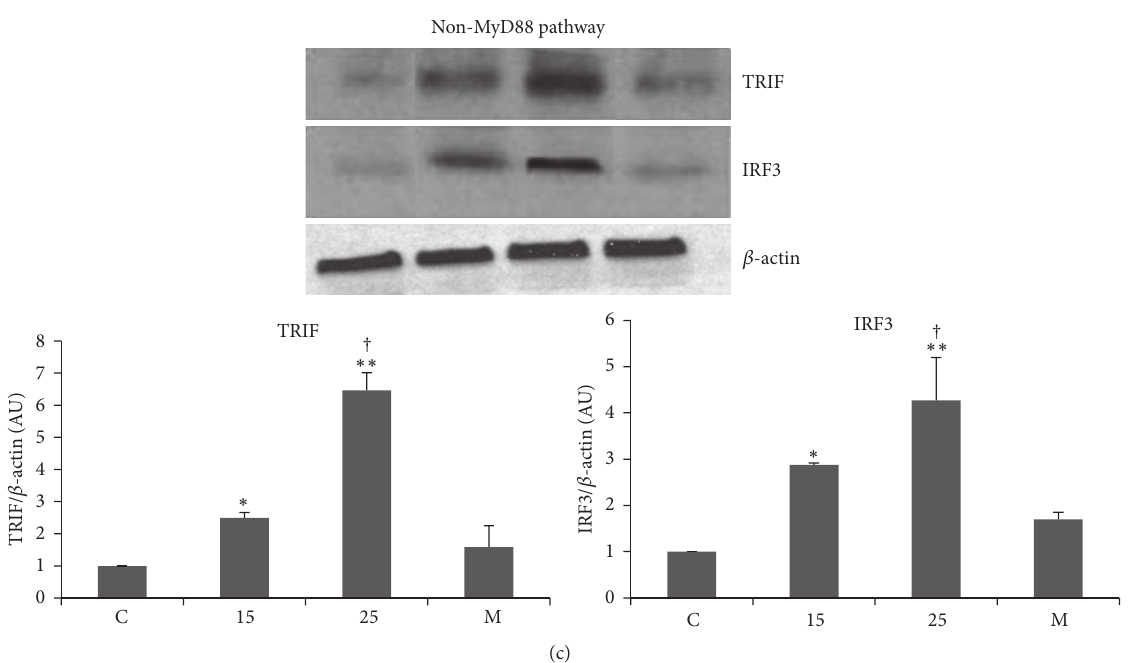
Figure 2: High glucose induces both MyD88 and Non-MyD88 pathways: HMVRECs were incubated and treated with 5.5, 15, and 25mM glucose and mannitol as described in Methods and legend of Figure 1 and protein lysates were harvested. (a) Western blots showing increased MyD88 protein levels normalized against 𝛽 -actin. ∗ 𝑃 < 0.01 versus control and ∗∗ 𝑃 < 0.001 versus control. † 𝑃 < 0.05 versus 15 mM, (b) increasednuclearp65levelswithHGtreatment. ∗ 𝑃 < 0.001 versuscontrol. † 𝑃 < 0.05 versus15mM,(c)representativeblotsshowingincreased TRIF and IRF3 protein levels with HG. Blots are normalized against 𝛽 -actin. TRIF: ∗ 𝑃 < 0.05 versus control; ∗∗ 𝑃 < 0.001 versus control; IRF3: ∗ 𝑃 < 0.01 versus control, ∗∗ 𝑃 < 0.001 versus control, and † 𝑃 < 0.05 versus